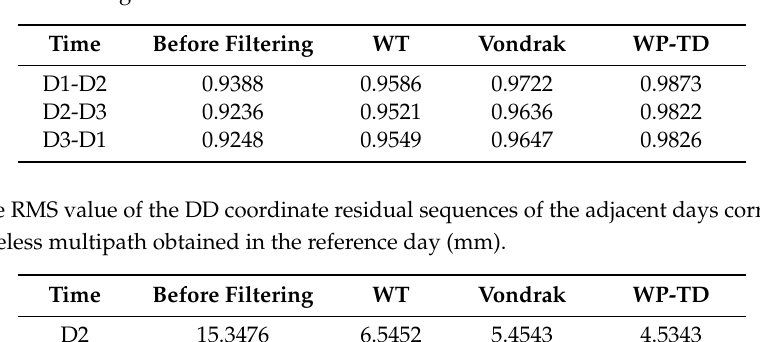
Table 6. Correlation coe ffi cient of the DD coordinate residual sequence of the three days after being denoised by the three algorithms.